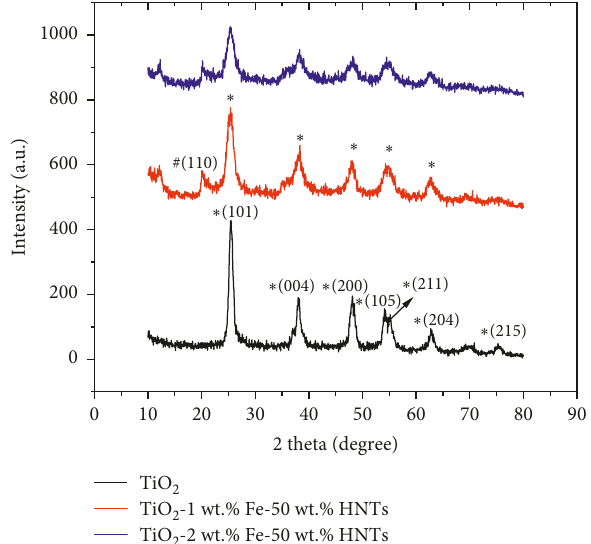
Figure 4: X-ray diffraction pattern of TiO and “#” represents the crystallographic planes of TiO 2 and HNTs, respectively).